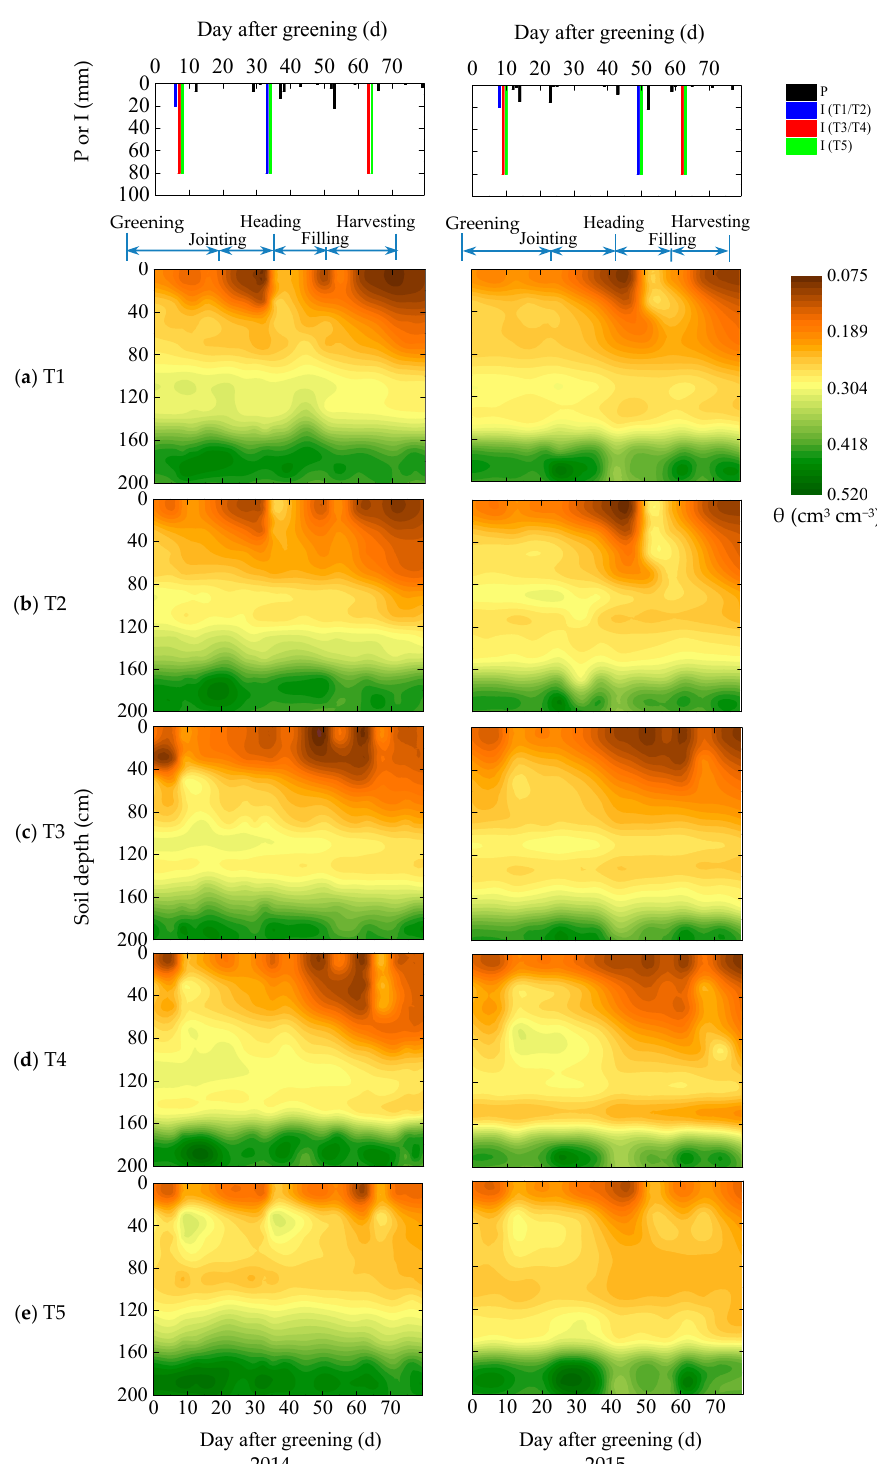
Figure 3. Seasonal variations in the soil moisture under the ( a ) T1, ( b ) T2, ( c ) T3, ( d ) T4, and ( e ) T5 treatments.